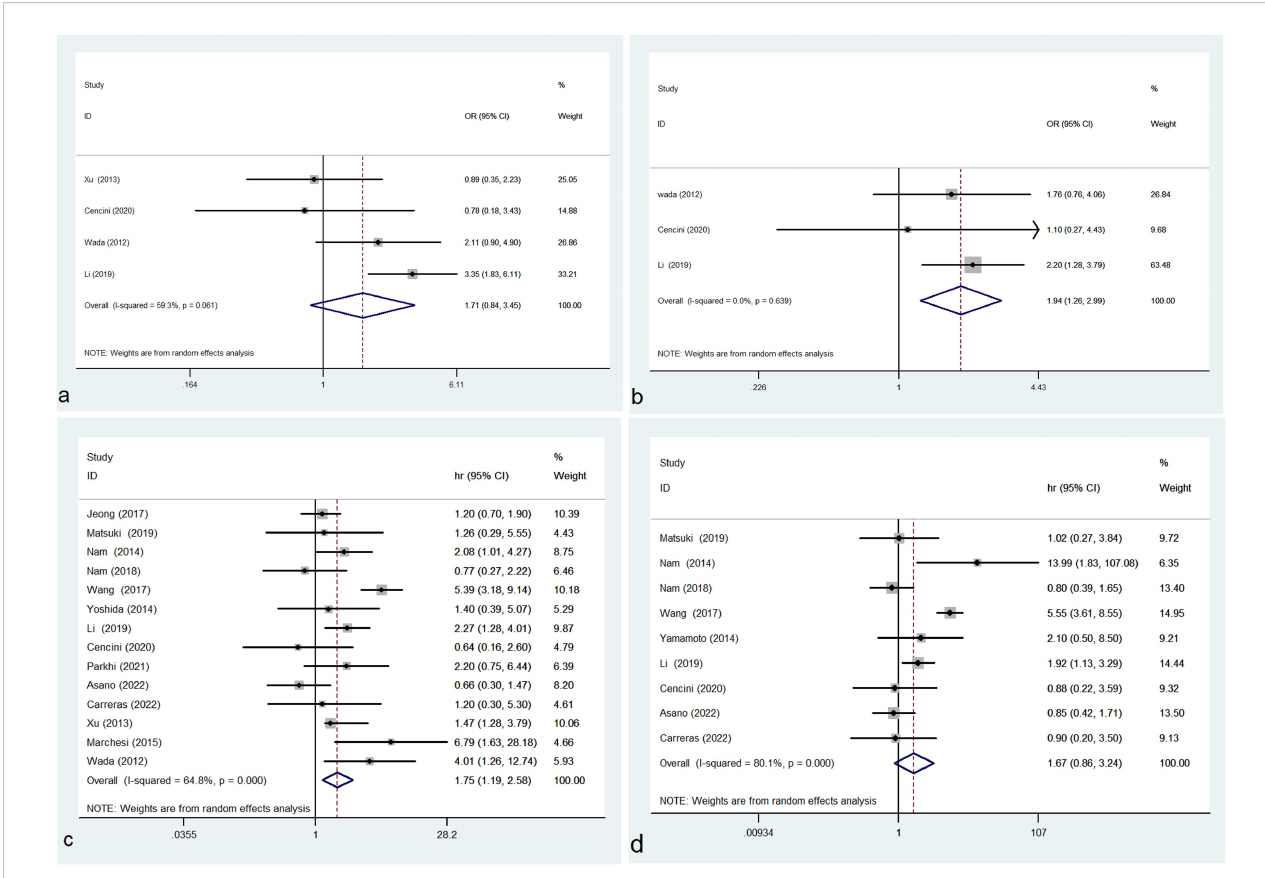
FIGURE 3 Forest plot of M2 TAMs and IPI (A) , disease stage (B) , OS (C) and PFS (D) ; OR, odds ratio; hr, hazard ratio; CI, con fi dence